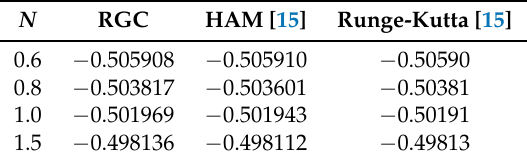
Table 2. Comparison of RGC, HAM and Runge-Kutta solution of C (cid:48) Sc = 0.24 and K = 0.2.